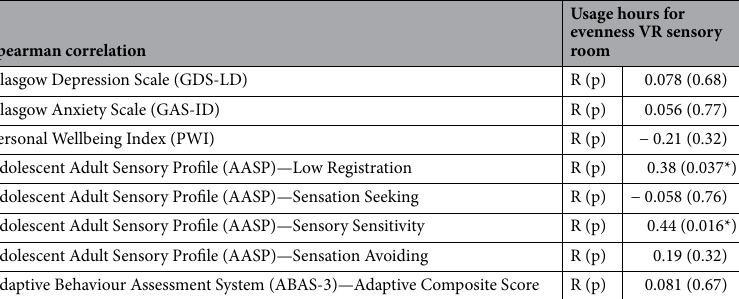
Table 4. Spearman Correlation of mean difference between pre and post scores and participant VR Sensory Room usage hours. R Spearman Correlation Score. *Significant at 0.05 level. p significance